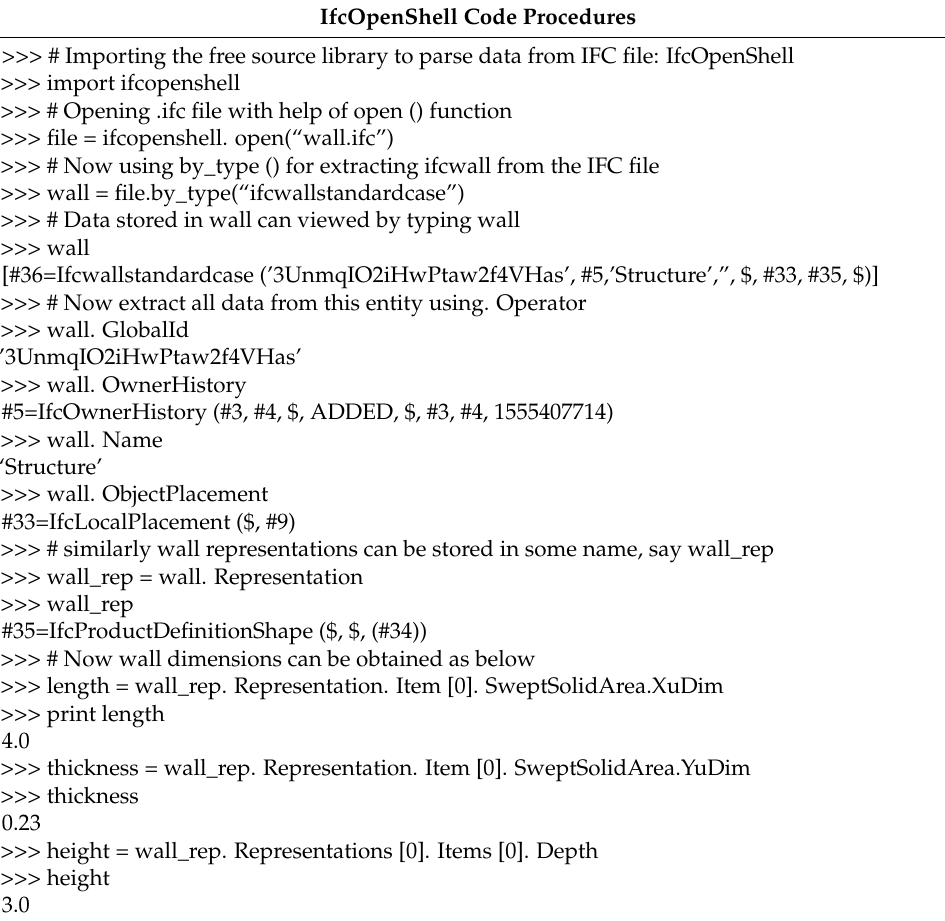
Table 2. Procedures for Drawing the Required Data Using